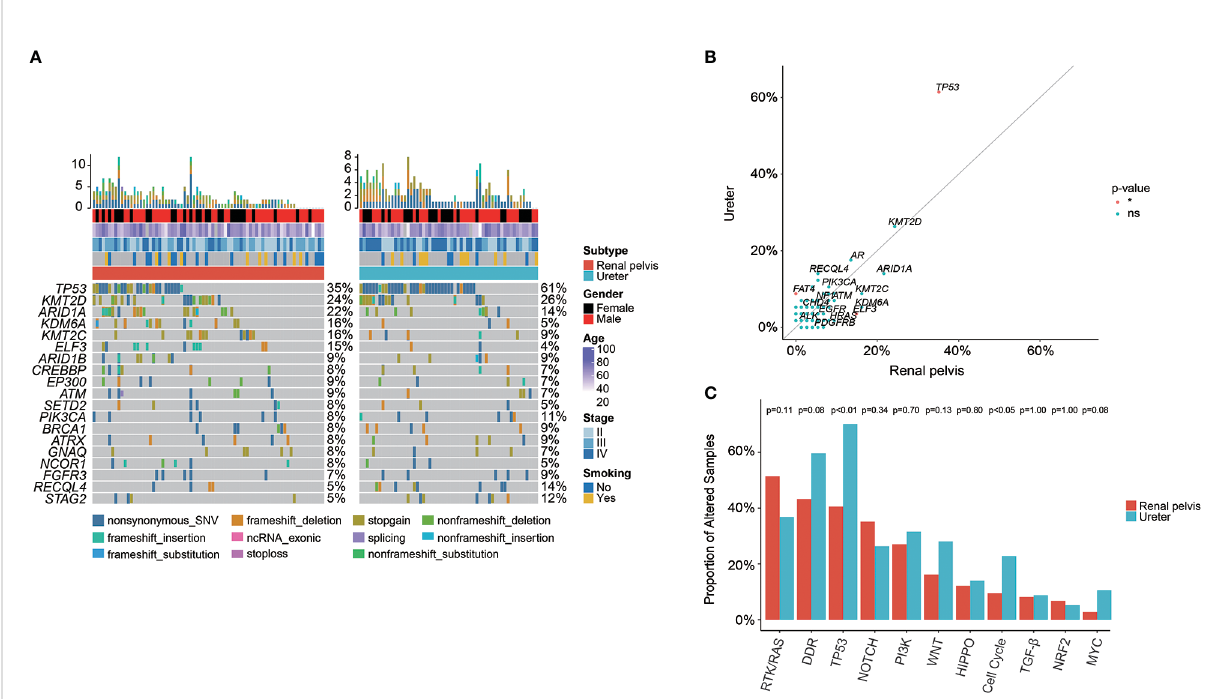
FIGURE 5 Genomic differences between renal pelvis and ureter tumors in the Chinese cohort. (A) Comparison of the most prevalently altered genes between renal pelvis and ureter. (B) Enrichment of GAs for renal pelvis and ureter tumors. (C) Comparison of the differences in the prevalence of commonly altered molecular pathways between renal pelvis and ureter. *: p < 0.05. ns, not signi fi